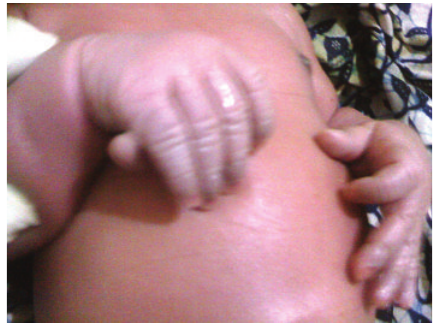
Figure 2: The 6 digits of right hand. The cutaneous nubbin is seen on the ulnar side of both hands.